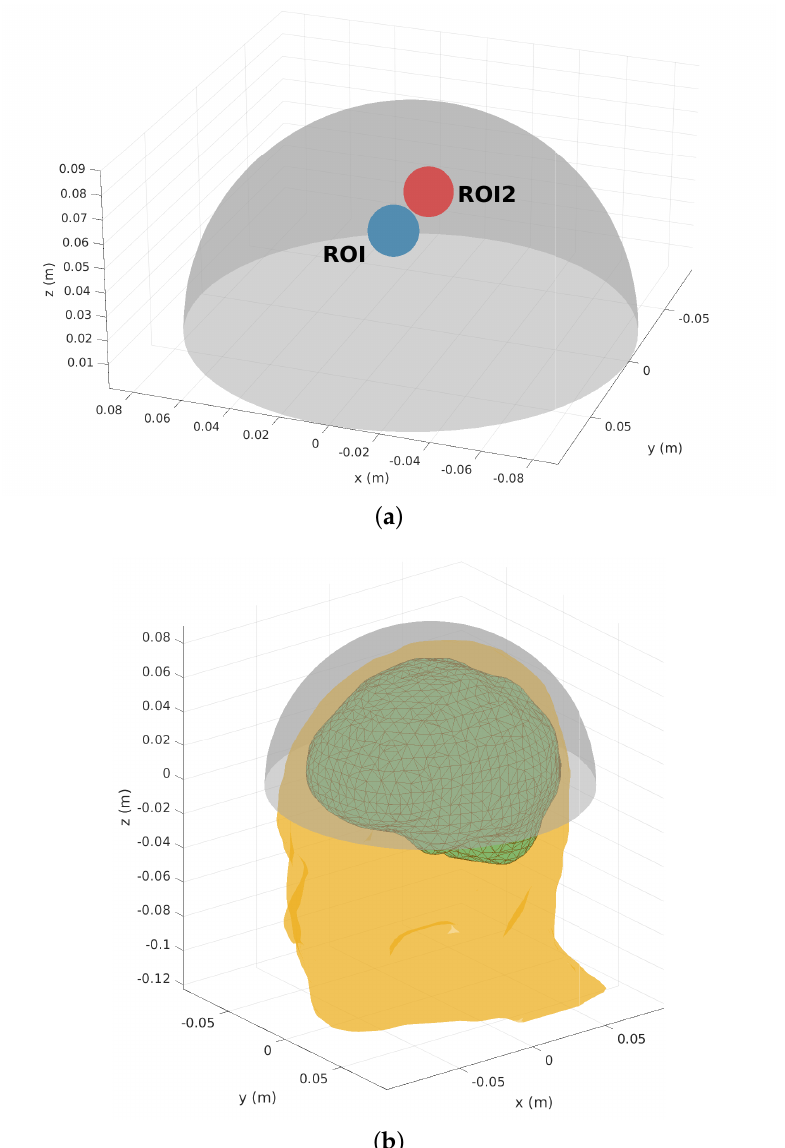
Figure A1. ( a ) Description of hemispherical surface where the optimal ψ must been found along with the spherical regions of interest ROI and ROI2 where the electric field must be maximized and minimized respectively. ( b ) Description of the two compartment scalp-brain